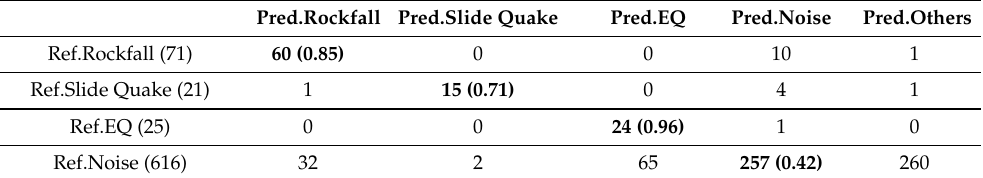
Table 7. Classification results of the additional manually expert-verified events from continuous data a . Pred.Rockfall Pred.Slide Quake Pred.EQ Pred.Noise